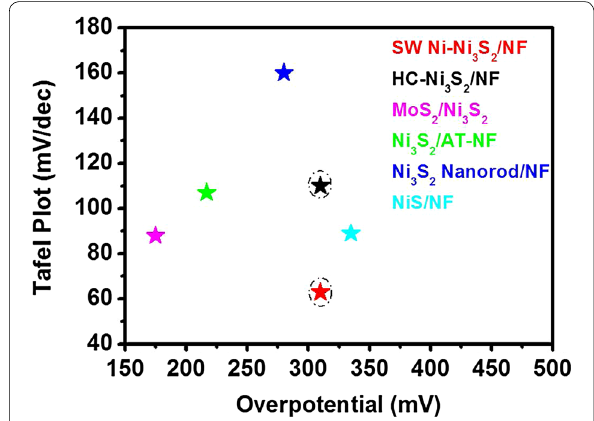
Fig. 6 OER activity comparison graph showing Tafel slope (mV/dec) with overpotential (mV) in alkaline